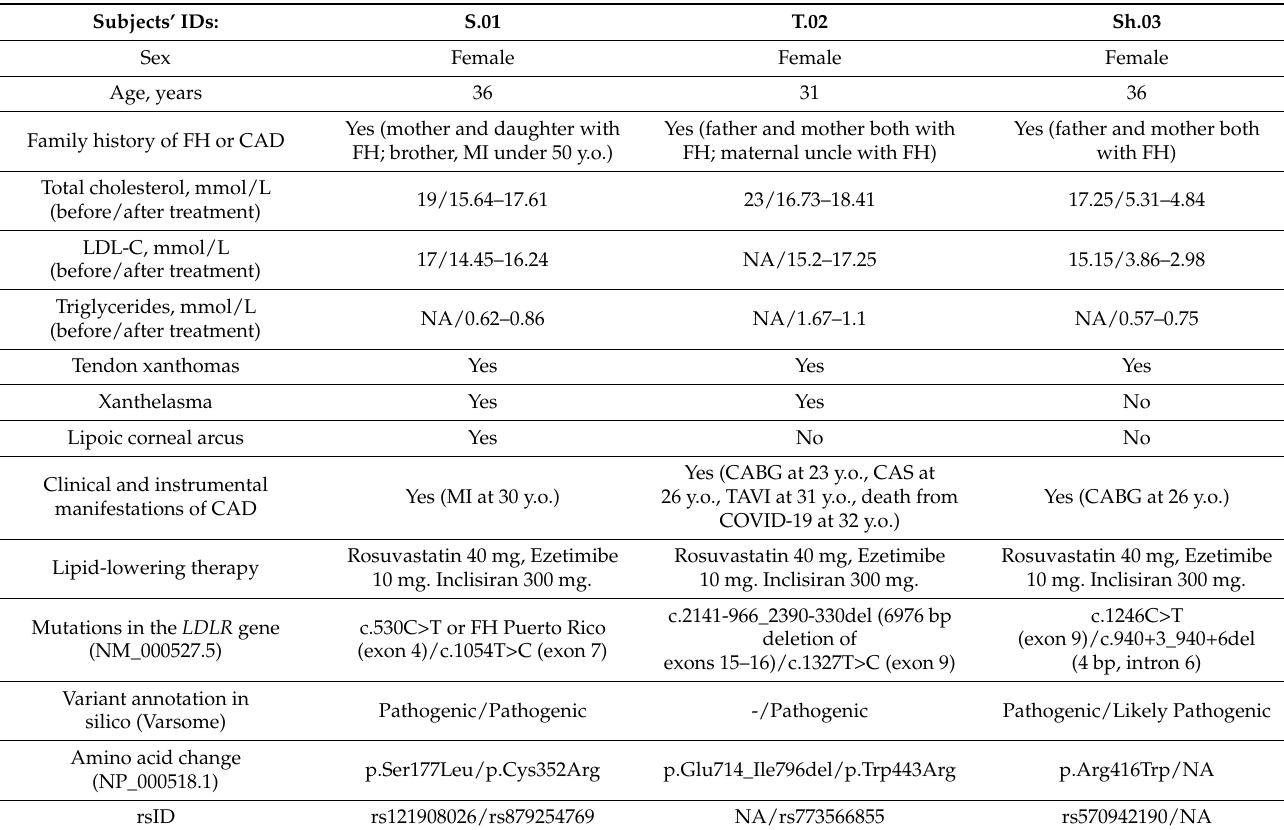
Table 1. Characteristics of the patients with